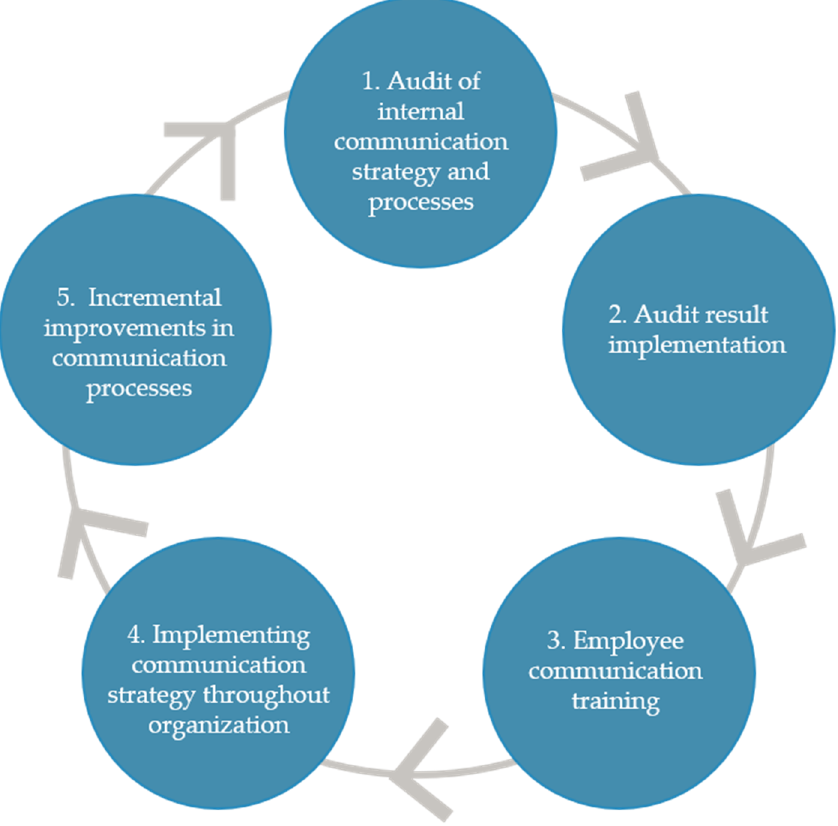
Figure 2. Communication strategy improvement cycle.